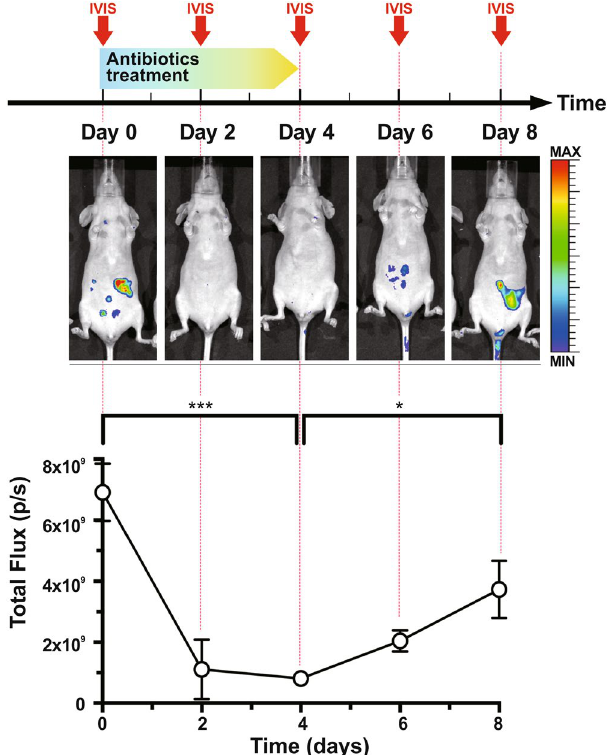
Figure 4. Reduction of intestinal bacterial β G by an antibiotic treatment. Upper panel: Experimental schedule for a 4-day antibiotic treatment and whole-body imaging by the IVIS ® imaging system (arrow). Whole-body imaging was performed every 2 days. Antibiotics were orally administered twice daily for 4 days. Middle panel: Imaging of mice at day 0, 2, 4, 6, and 8. Lower panel: Total flux in abdomens of mice (n = 5). Error bars indicate SEM. * P value < 0.05. *** P value <